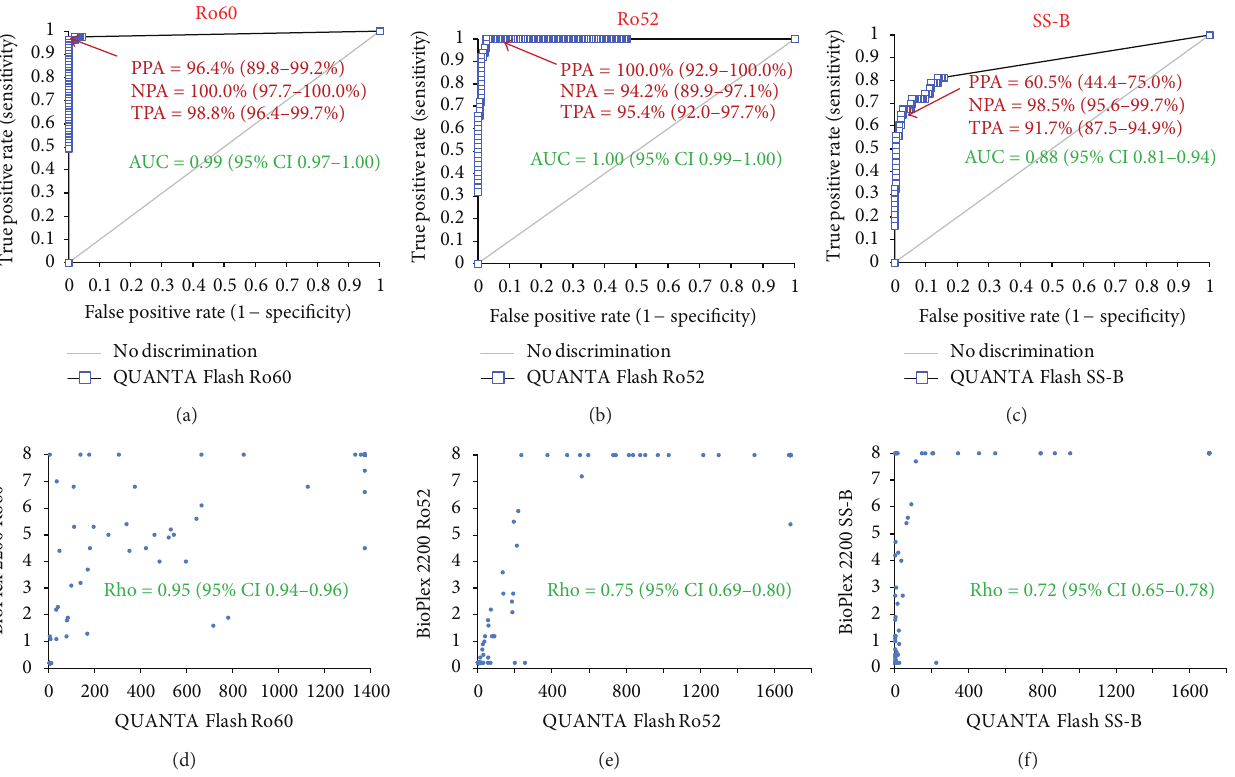
Figure 1: Comparison of QUANTA Flash with BioPlex 2200 as comparative method. Receiver operating characteristic (ROC) curves are shown in (a)–(c) and Spearman’s correlation diagrams in (d)–(f). Note: A significant portion of positive samples are above the analytical measuring range of BioPlex which biases the Spearman rho values. PPA/NPA/TPA: Positive/Negative/Total % agreement. AUC: area under the